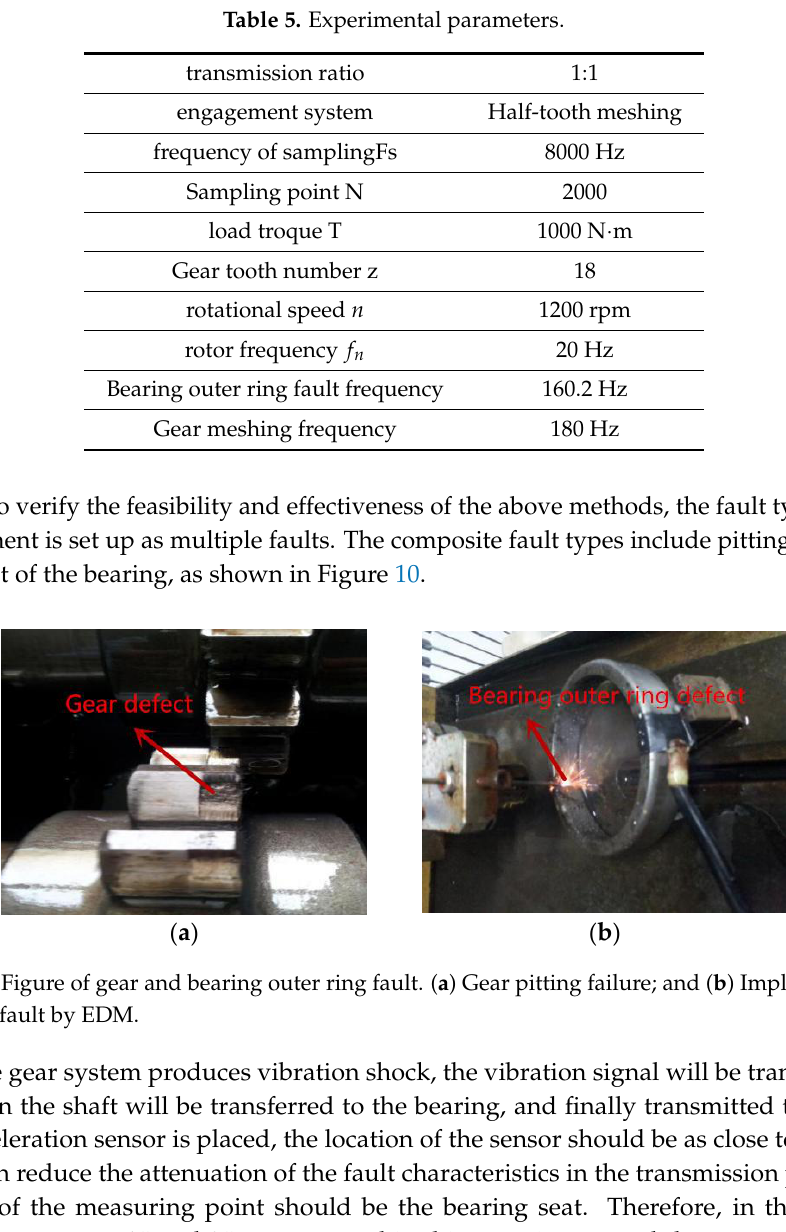
Figure 11. Time-frequency spectrum of complex fault signal of gear box. ( a ) Time domain of complex fault vibration signal; and ( b ) Spectrum of complex fault vibration signal.